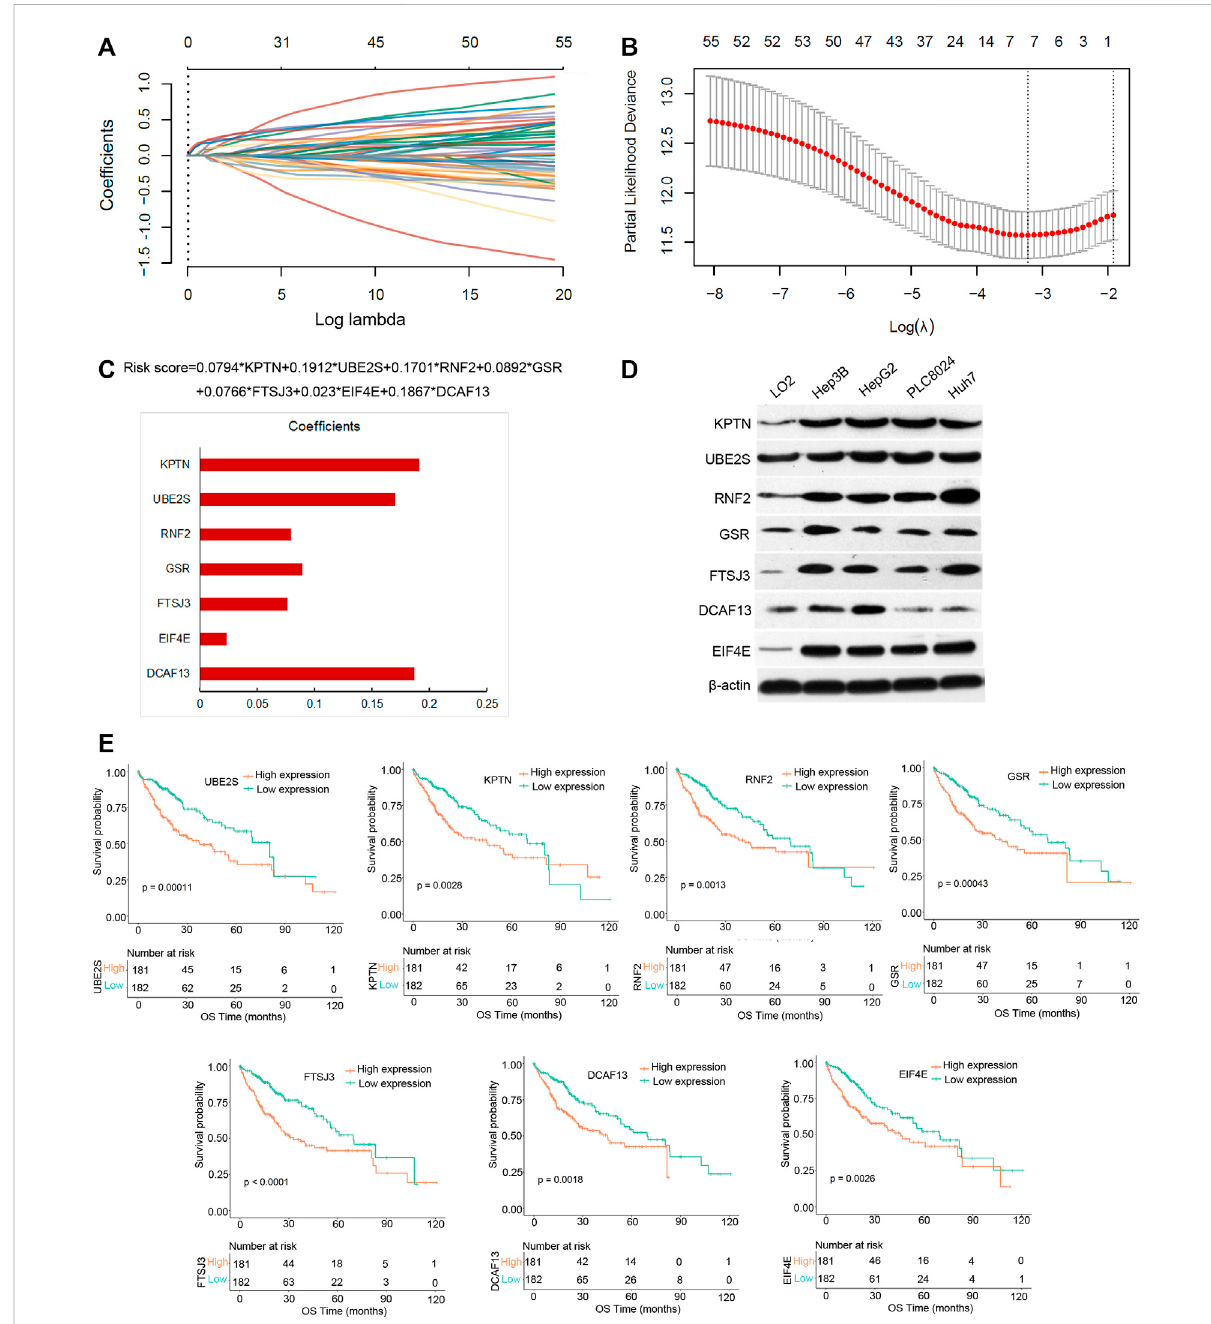
FIGURE 6 Sevenpyroptosis-regulatedgeneswithprognosticvalueinthetraininggroup. (A) TheLASSOcoef fi cientpro fi lesofthe57pyroptosis-regulated genes. (B) Cross-validationplotforthepenaltyterm. (C) Theriskscoreformulaandthecoef fi cientsofsevenpyroptosis-regulatedgenes. (D) Western blotting results showing the expression level of the seven pyroptosis-regulated genes in four HCC cell lines (Hep3B, HepG2, PLC8024, and Huh7) and one normal hepatocyte cell line (LO2). (E) Survival analysis of seven pyroptosis-regulated genes by the Kaplan-Meier Plotter